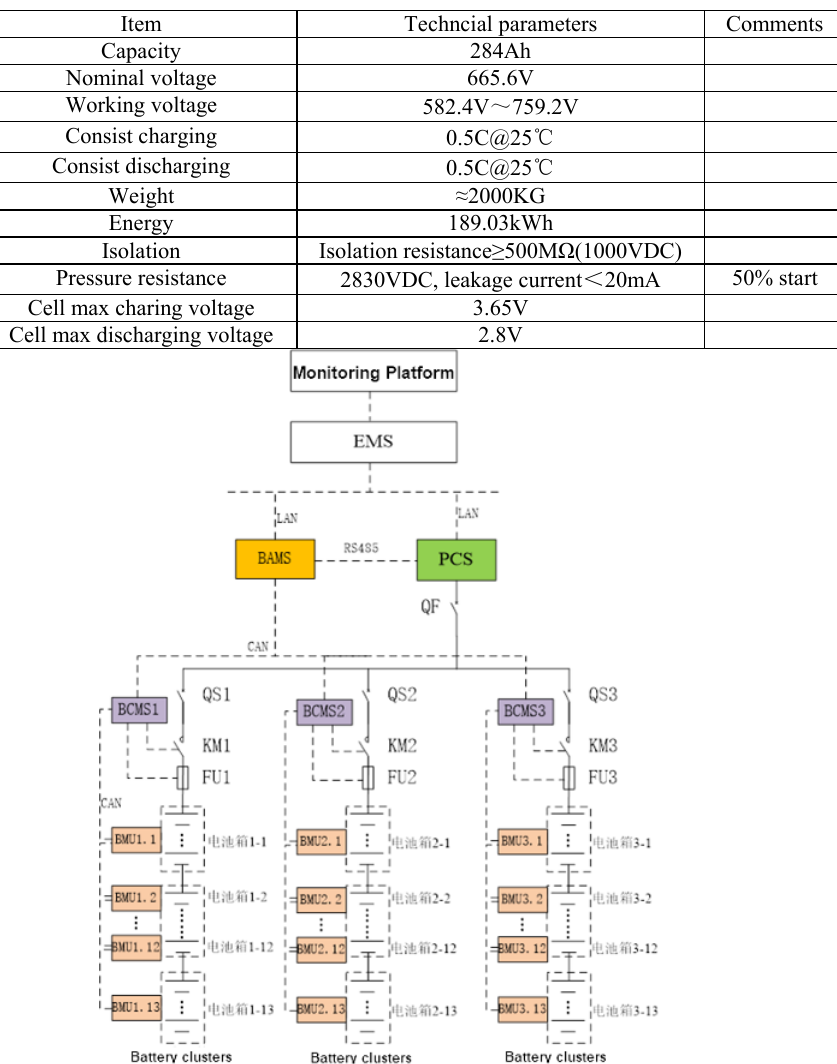
Table 3. Battery cluster